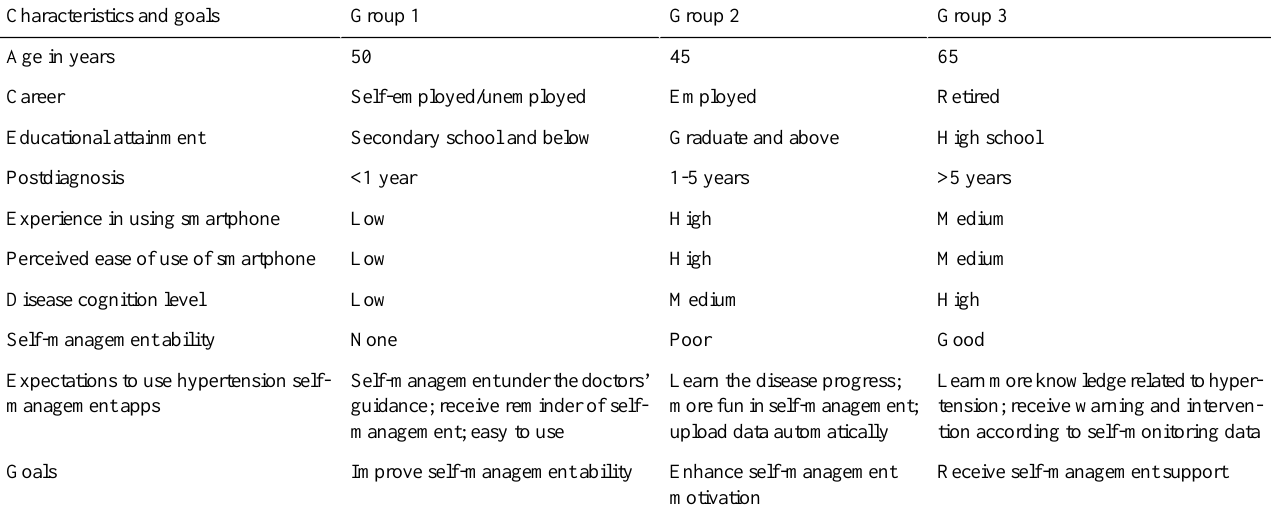
Table 4. Personas of hypertensive